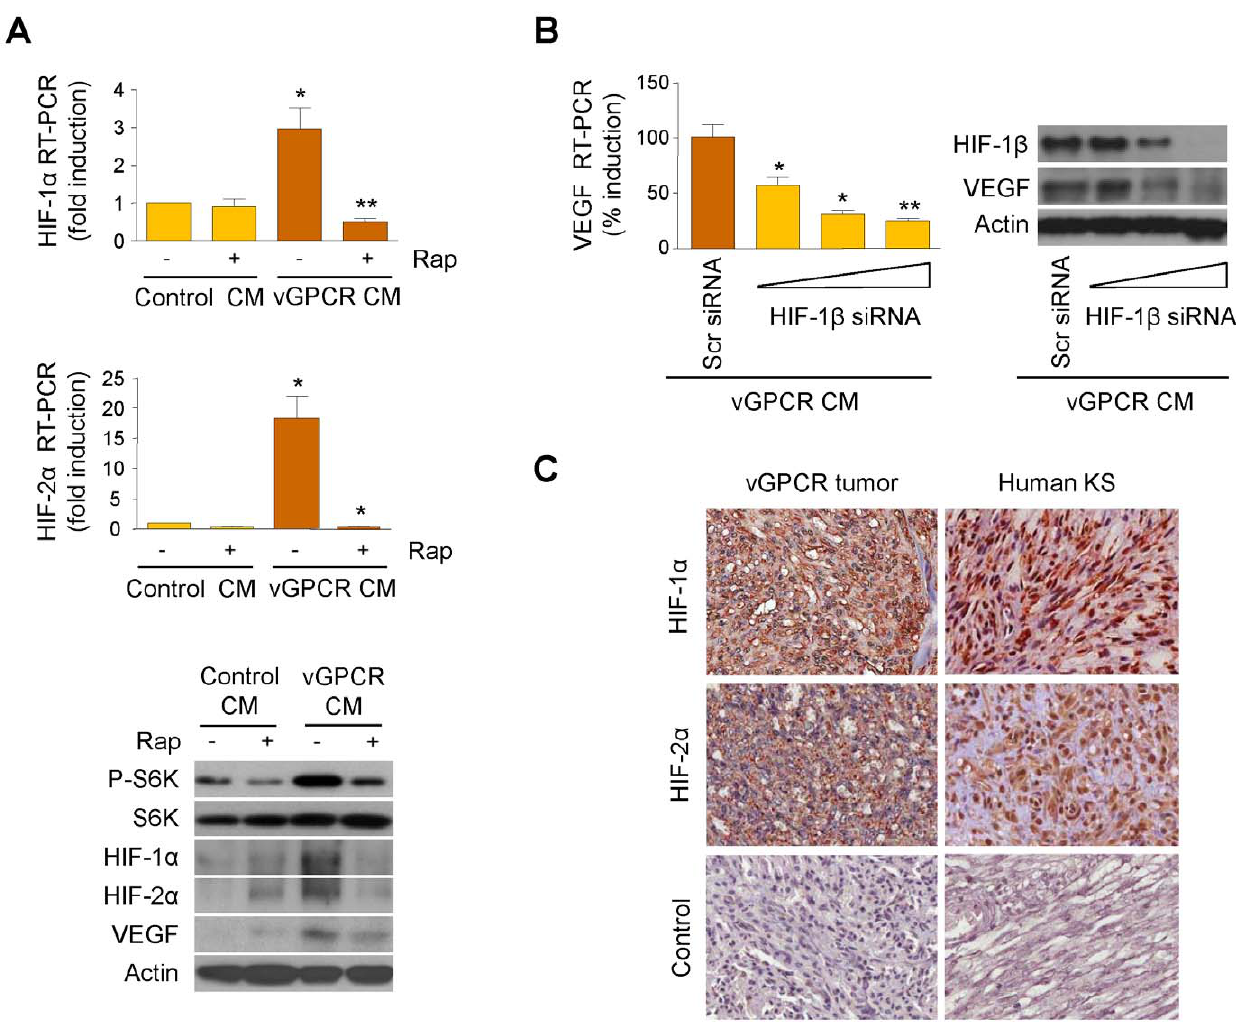
Figure 3. Upregulation of HIF-1 a /2 a by vGPCR paracrine secretions. (A) HMEC1s were exposed to media conditioned by control (Control CM) or vGPCR-expressing cells (vGPCR CM), in the presence of vehicle or Rapamycin (50 m M). mRNA levels of HIF-1 a and HIF-2 a and protein levels of HIF- 1 a , HIF-2 a and VEGF are shown. (B) HMEC1s were transfected with increasing doses (20, 40 and 80 nM) of HIF-1 b siRNA or Scrambled siRNA. Cells were then exposed to media conditioned by vGPCR-expressing cells. VEGF mRNA levels are shown. (C) Immunohistochemical analysis of HIF-1 a and HIF-2 a , and staining using an isotype-matched control antibody, in vGPCR tumor and human KS.